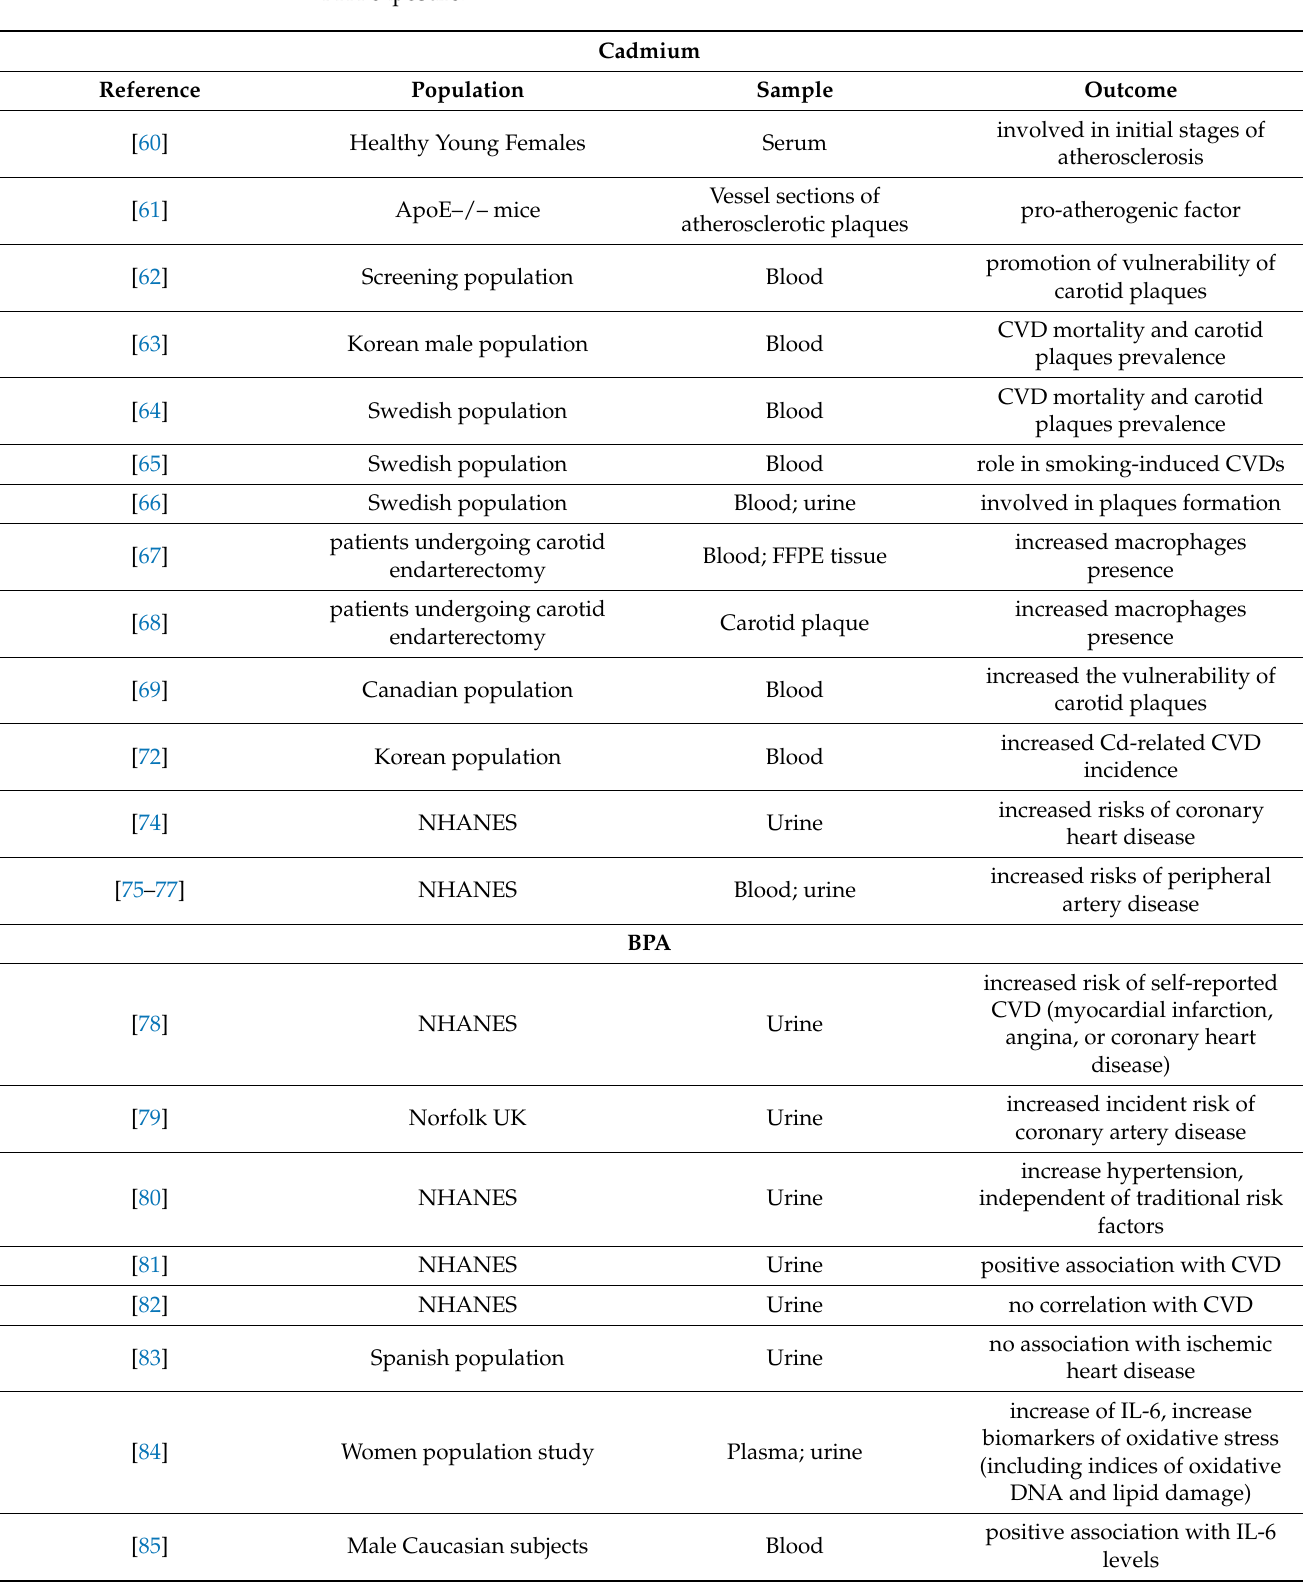
Table 2. Summary of clinical studies investigating the association between cadmium and BPA